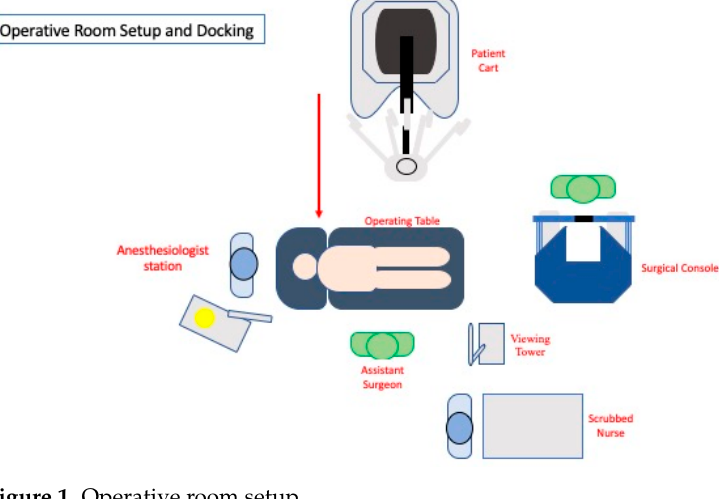
Figure 1. Operative room setup.